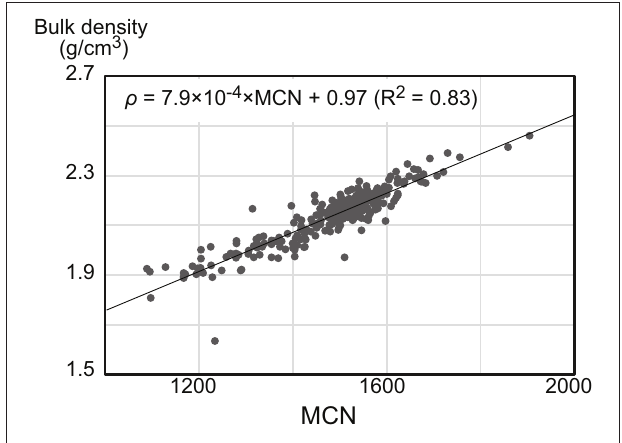
FIGURE 4 | Relationship between mean CT number (MCN) and bulk density ( ρ ) data of the mud/mudstone of the IODP Site C0023. Bulk density data are from Heuer et al.